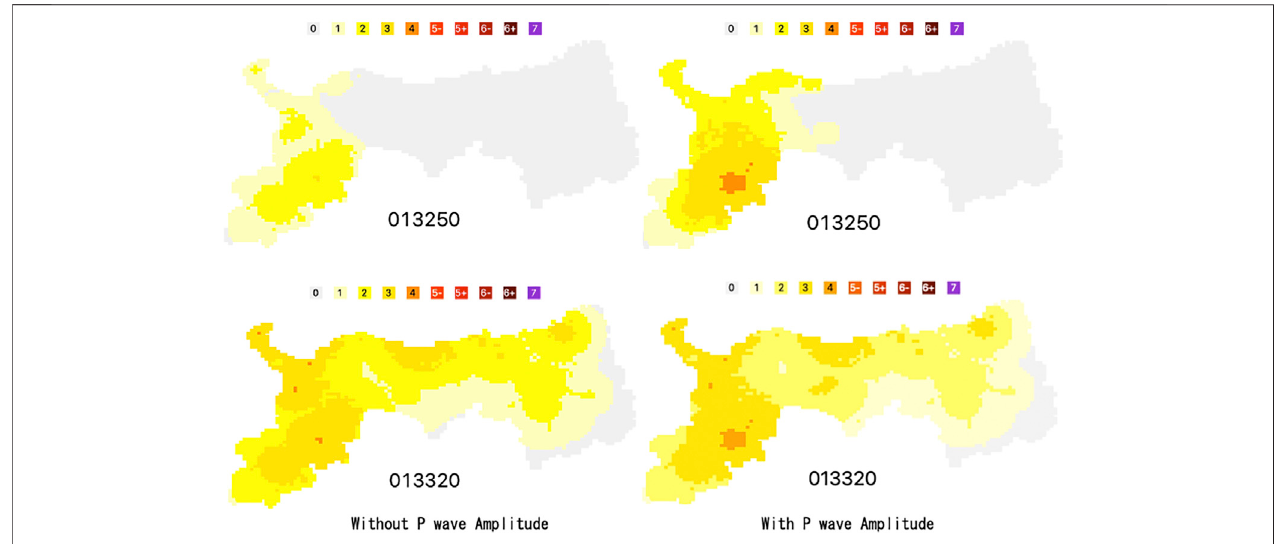
Frontiers in Earth Science |